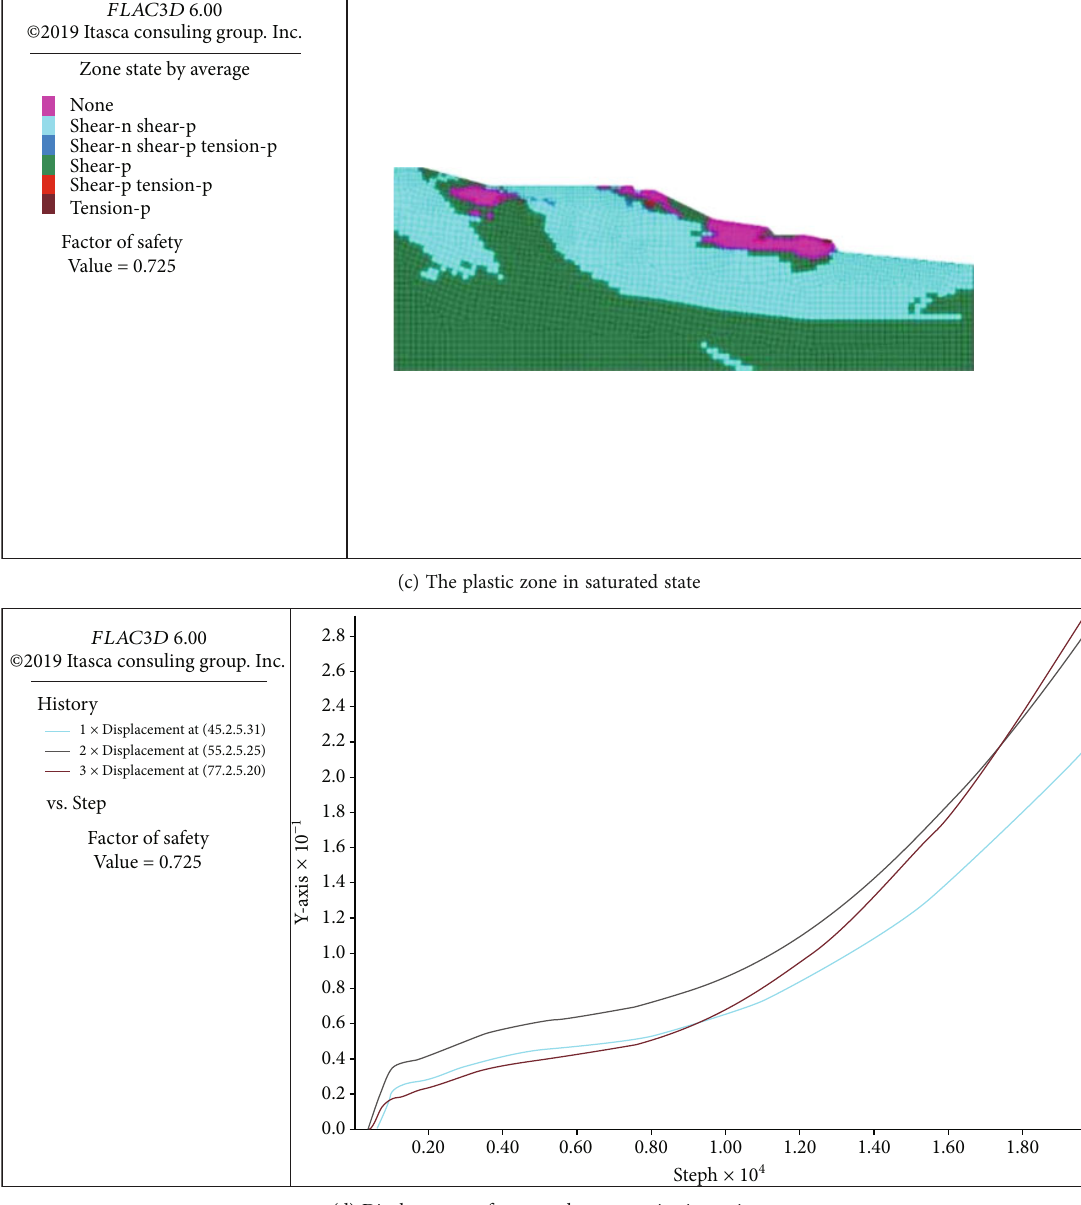
Figure 16: The stability of slope in saturated